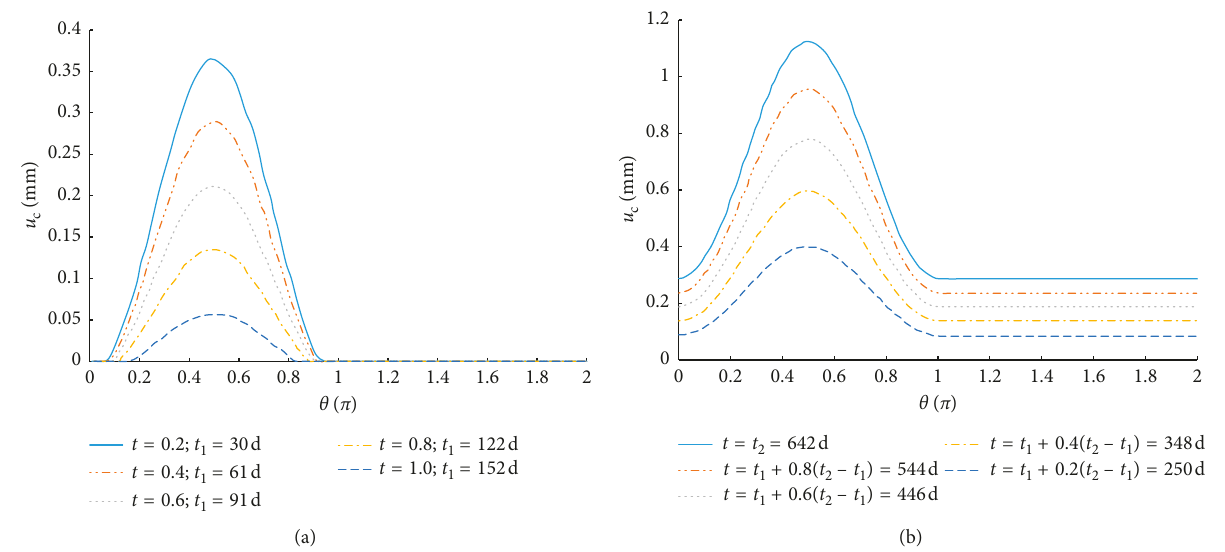
Figure 6: Distribution of concrete radial displacement u